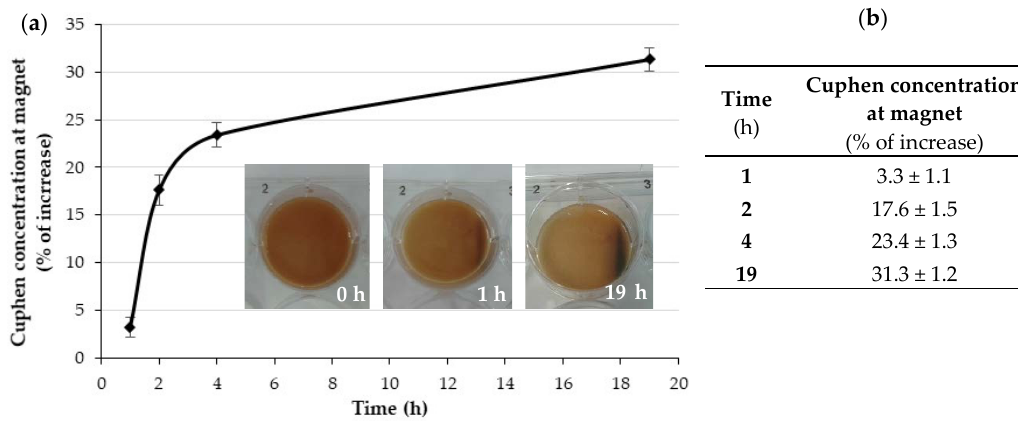
Figure 6. In vitro setup of the magnetic properties of Cuphen liposomes containing IONPs. ( a ) Graphical representation of Cuphen increase over time. Liposomes were exposed to a magnetic field of 560.9 mT; ( b ) Percentage of Cuphen increase at the magnet region. Results are expressed as average ± SD of at least three independent experiments.